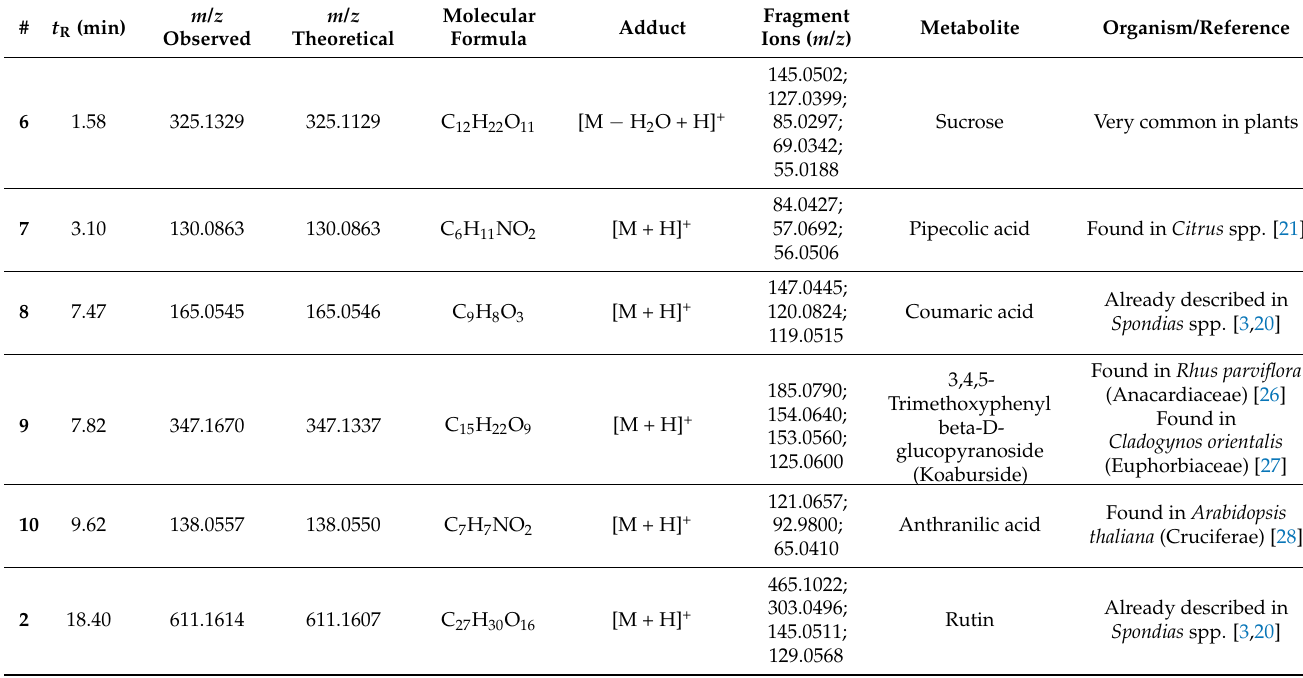
Table 3. Metabolites tentatively identified by LC-HRMS in positive ion